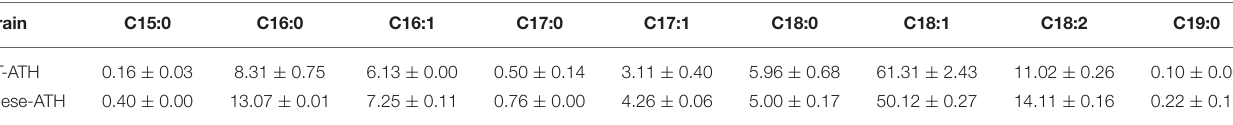
The values represent the means and standard deviations for two independent experiments.